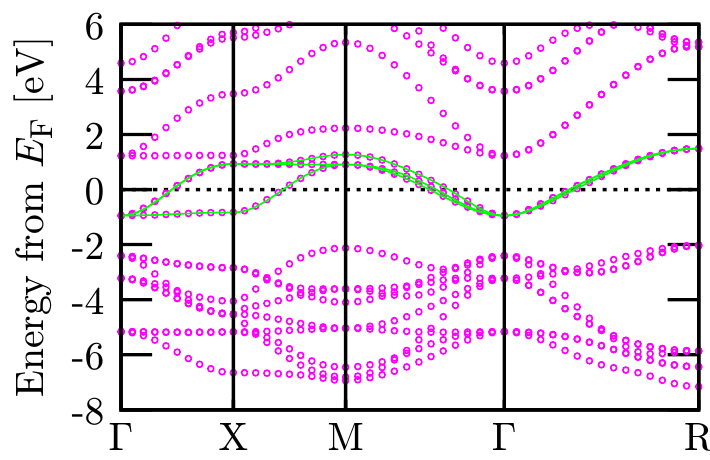
Figure 13: Comparison of LDA band structure and fit by the Wannier functions. The circles denote the energies computed by LDA and the solid lines denote the Wannier